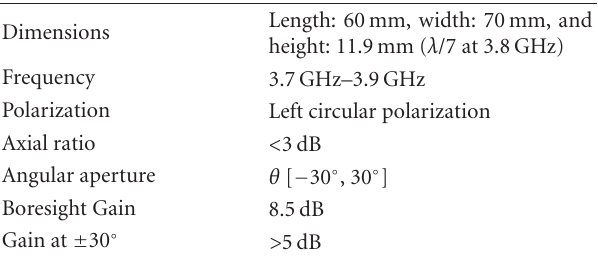
Table 1: Antenna specifications.